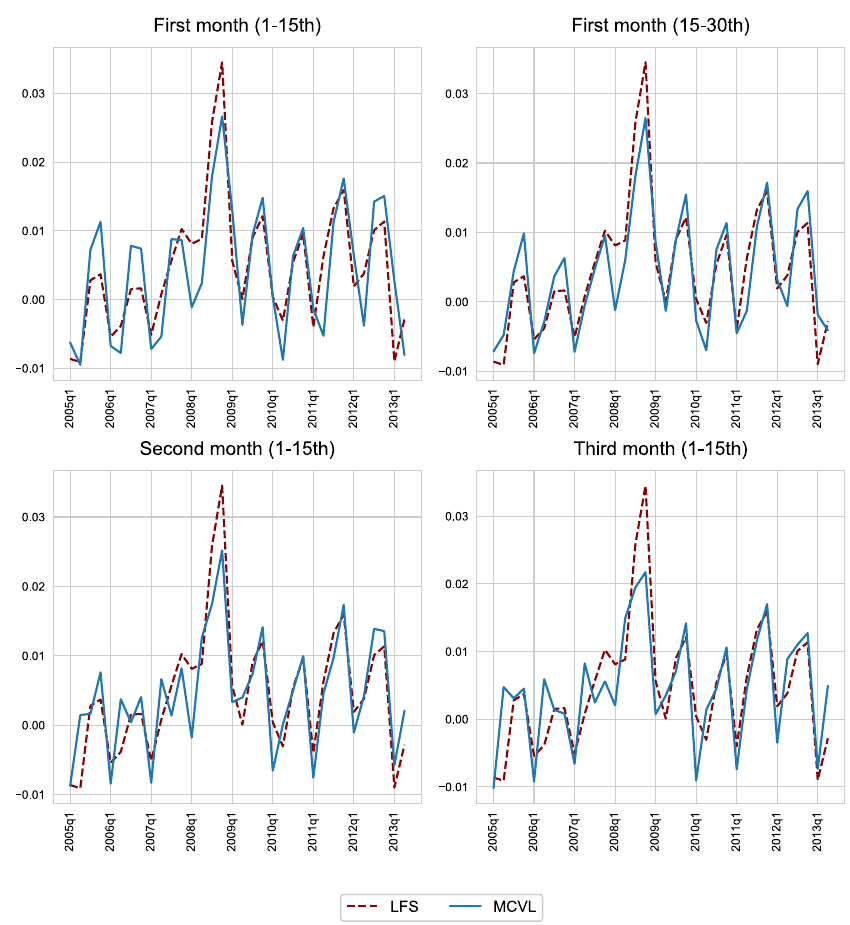
Fig. 28 Seasonality of unemployment by reference week, STU